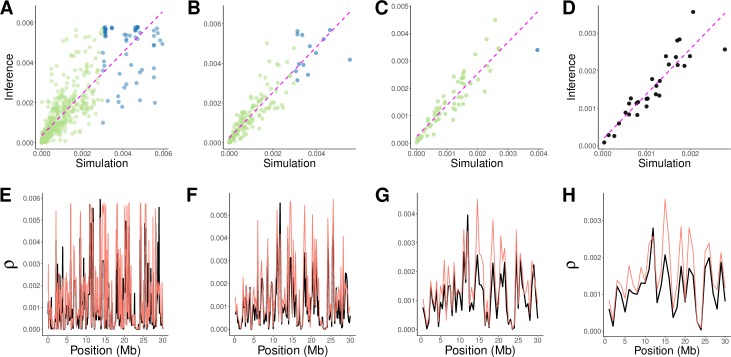
Inference of recombination maps in the presence of recent population growth.Each column represents a different bin size (increasing from left to right, 50 kb, 200 kb, 500 kb and 1 Mb). A-D, scatter-plots of inferred versus simulated maps, coloured according to the θ / ρ ratio (green > = 1, blue < 1). The dashed magenta line represents ordinary least squares regression. E-H, corresponding simulated (black) and inferred (orange) maps.